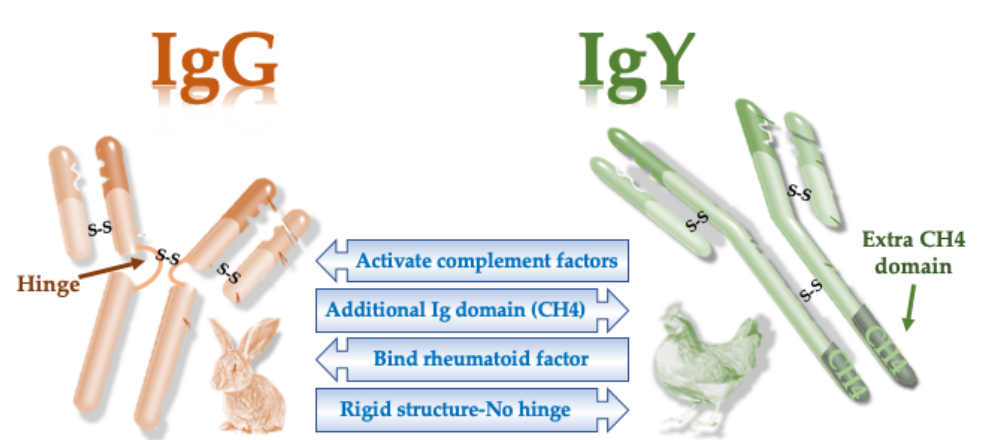
Figure 1. Main structural and functional differences between mammals and avian antibodies. S-S, disulfide bonds.